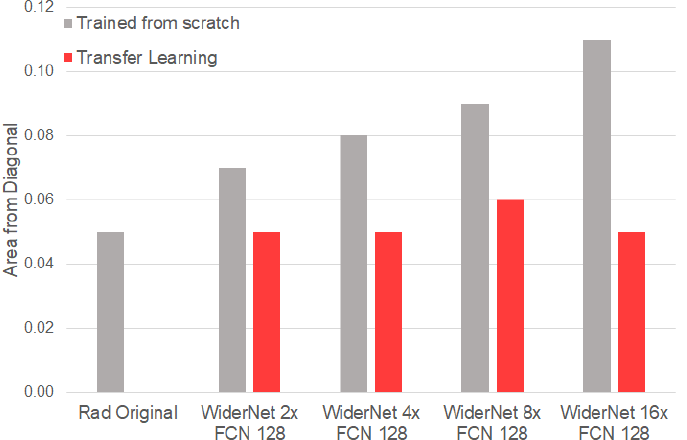
Figure 5. Area from the diagonal of reliability plots with and without transfer learning (TF). TF prevents this error metric from increasing as the model capacity increases. Best in